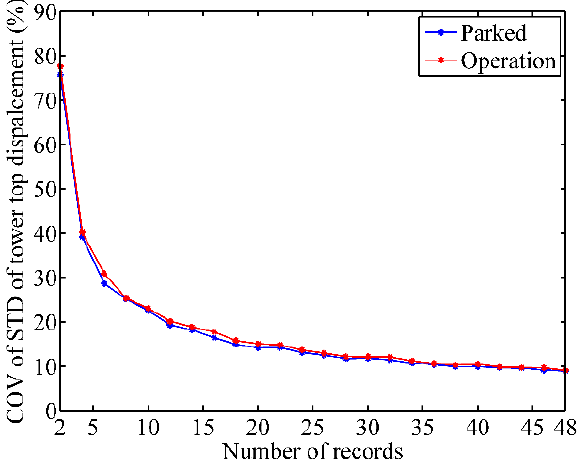
Figure 7. COV of the STD of maximum FA displacement with a different number of records.